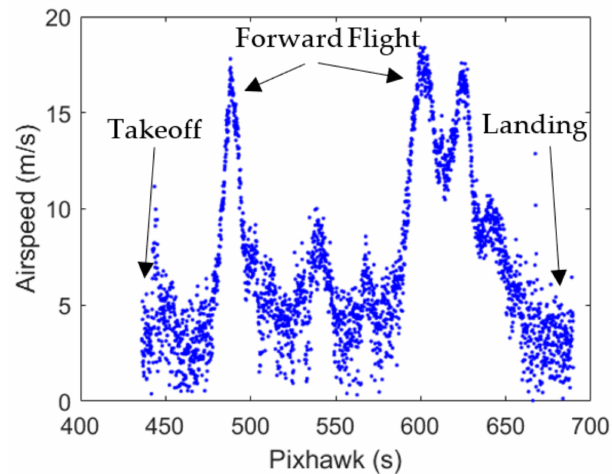
Figure 8. Airspeed flight